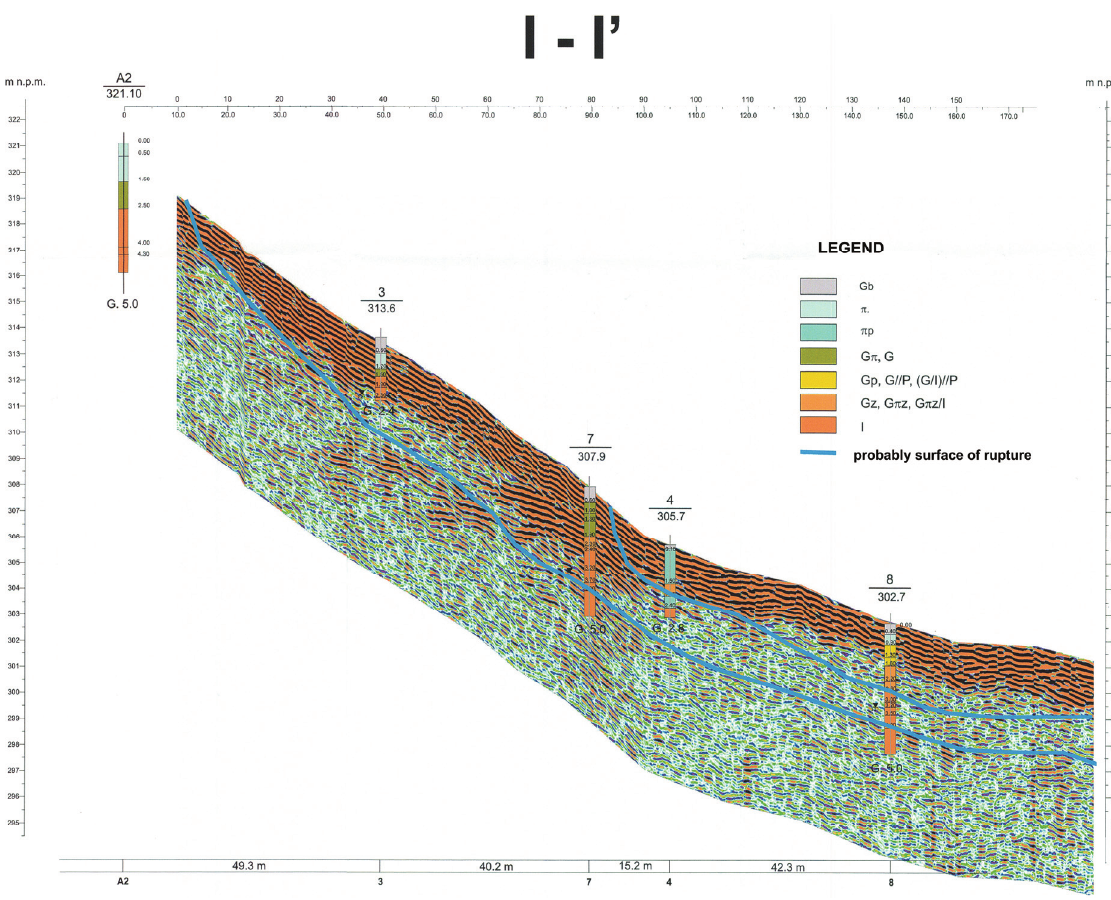
Fig. 8. Probably courses of the slide surface between particular